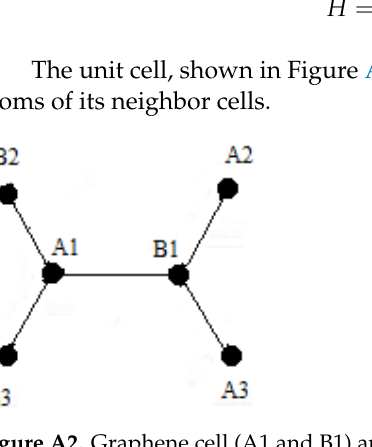
Figure A2. Graphene cell (A1 and B1) and its neighbors.